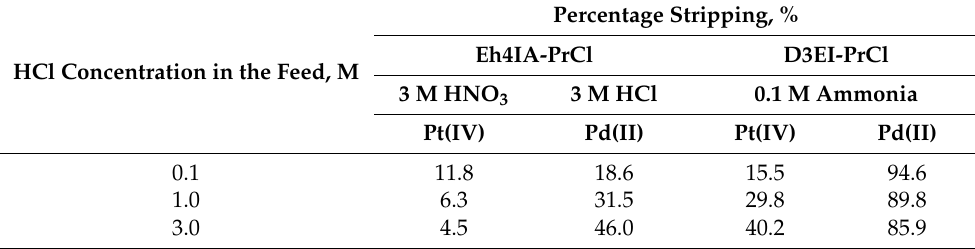
N/A—data not available. Table 8. The results of Pd(II) and Pt(IV) stripping from the loaded Eh4IA-PrCl and D3EI-PrCl organic solutions.